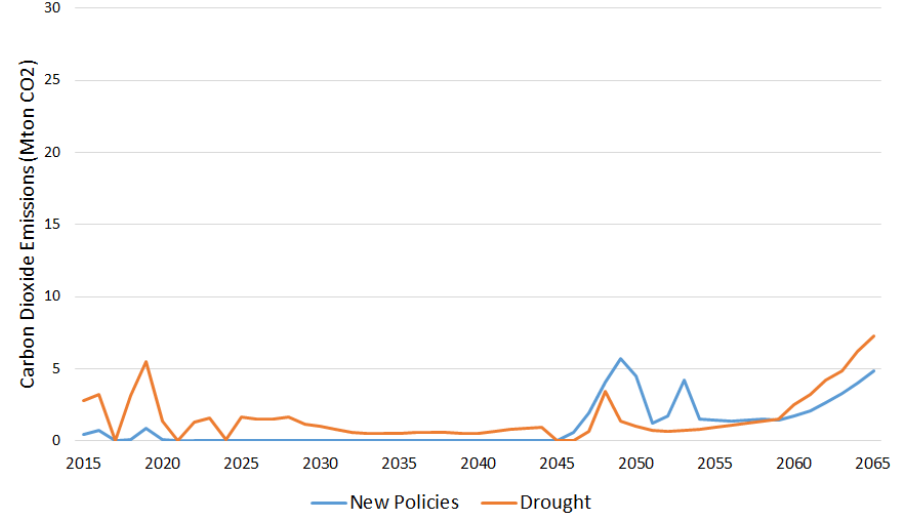
Figure 6. Comparison of carbon dioxide emissions between Drought and New Policy Scenarios.